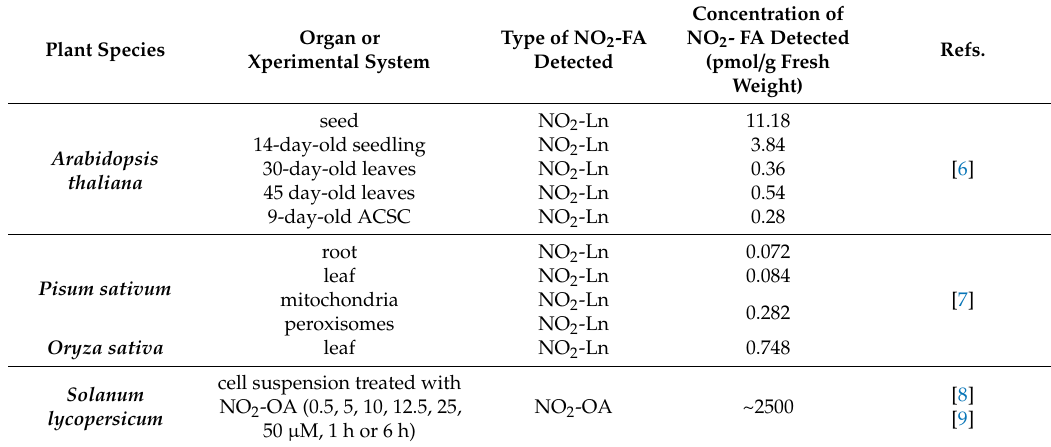
Table 2. Concentration values of free NO 2 -FA determined in di ff erent plant species and